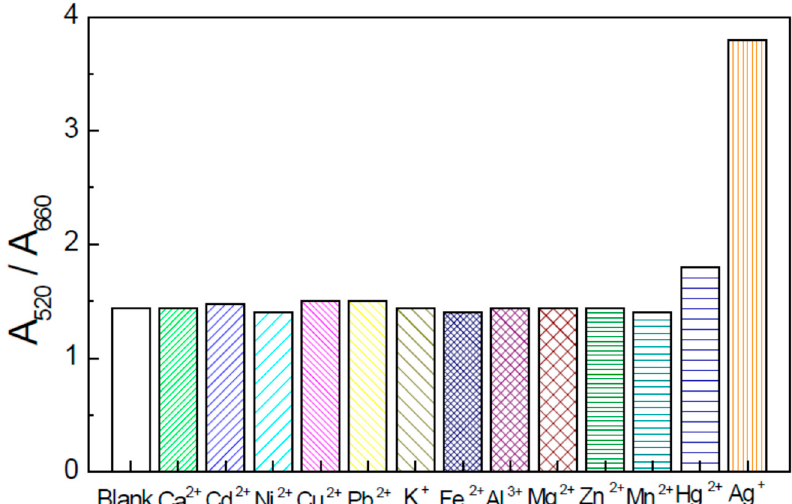
Figure 1. The graphical depiction of the sensor for Ag + ions selectivity and sensitivity compared to other metal ions based on data given in paper [38]. UV-Vis absorption ratio (A520/A660) of gold nanoparticles dispersions mixed with thiamazole in the presence of Ag + with a concentration of 5 nM. The concentration of Pb 2+ , Hg 2+ and Cu 2+ was 50 nM. The concentration of other ions was 100 nM (concentration of thiamazole was 2 µ M; pH: 7.5).